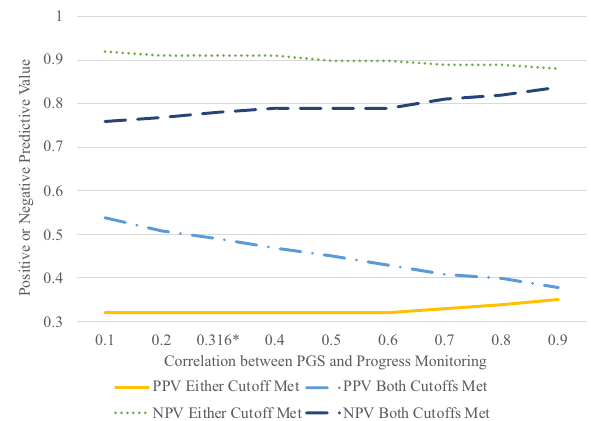
Fig. 2 Positive and negative predictive values of using PGS and progress monitoring scores as a screener for learning disabilities (20th percentile cutoff) with varied correlations between PGS and progress monitoring. This table represents when PGS predicts 10% of end-of-year achievement scorers and progress monitoring is correlated with end-of-year achievement at r = 0.55. PPV positive predictive value; NPV negative predictive value. *Represents the value reported in the article where the relation between PGS and progress monitoring is equal to the relation between PGS and